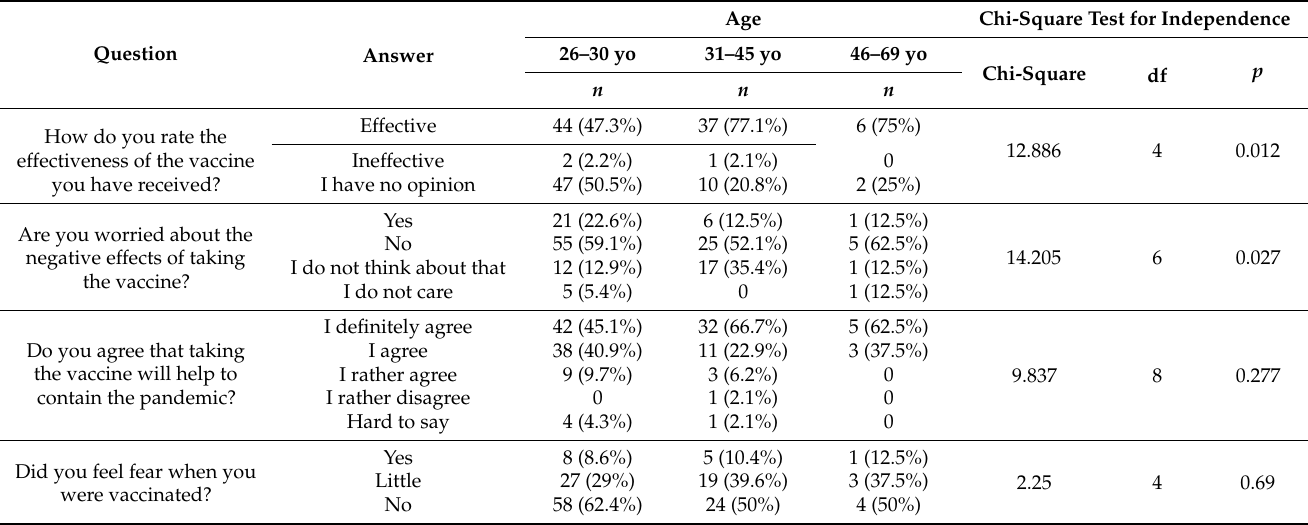
Table 2. Comparison of the answer of the given question with age.